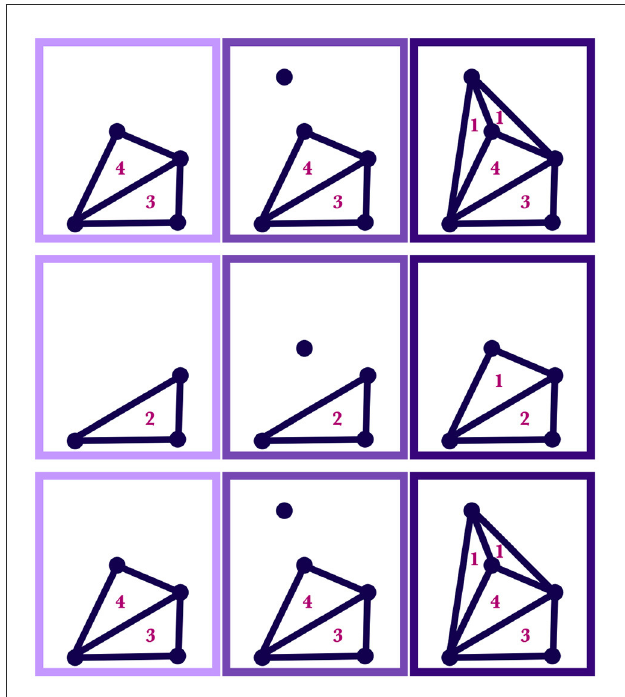
FIGURE6 Each row of panels shows how a silhouette region, SIL C , n ( t ), changes with the inclusion of an additional point, M ( t ). In a given row, the leftmost panel shows the initial region, SIL C , n ( t ), with the numbers indicating the weights; the middle panel shows the point to be added, M ( t ); the rightmost panel shows the new resulting shape and weighting of the region, SIL C , n + 1 ( t